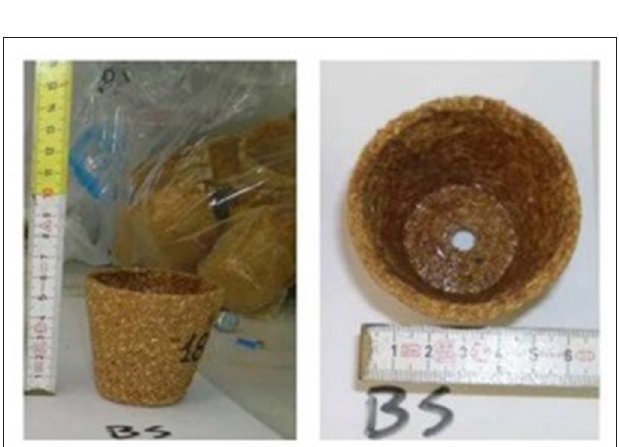
FIGURE 7 | Representation of the biodegradable pot (Source: Sartore et al., 2016